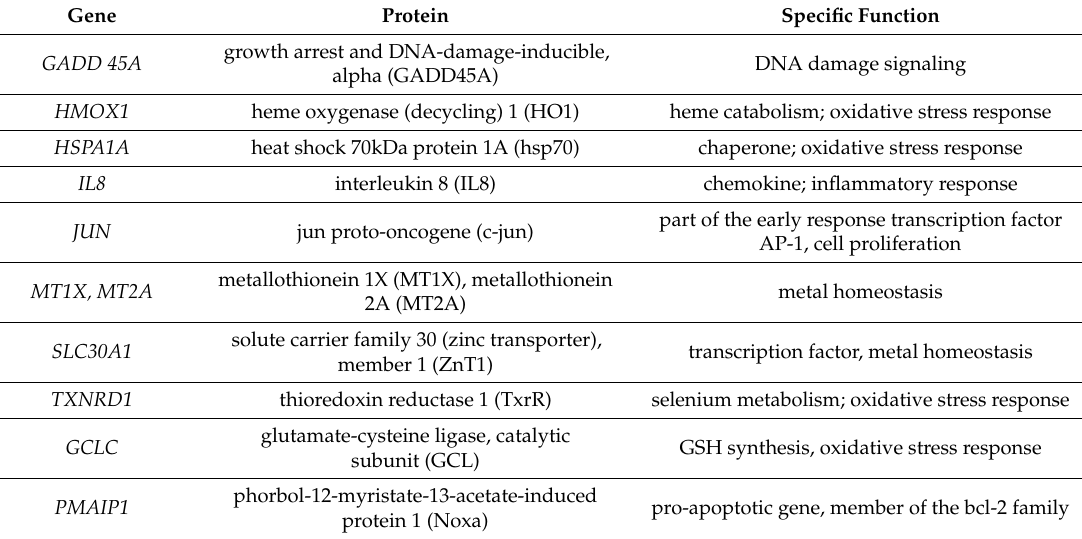
Table 2. Genes a ff ected in a relevant manner by the CuO particles in the presence or absence of the inhibitors OH-dyn and / or